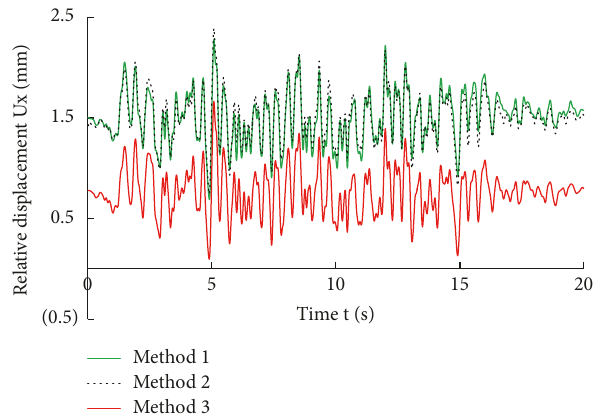
Figure 24: Time history of the X component relative displacement at 6.0 m height of dam.